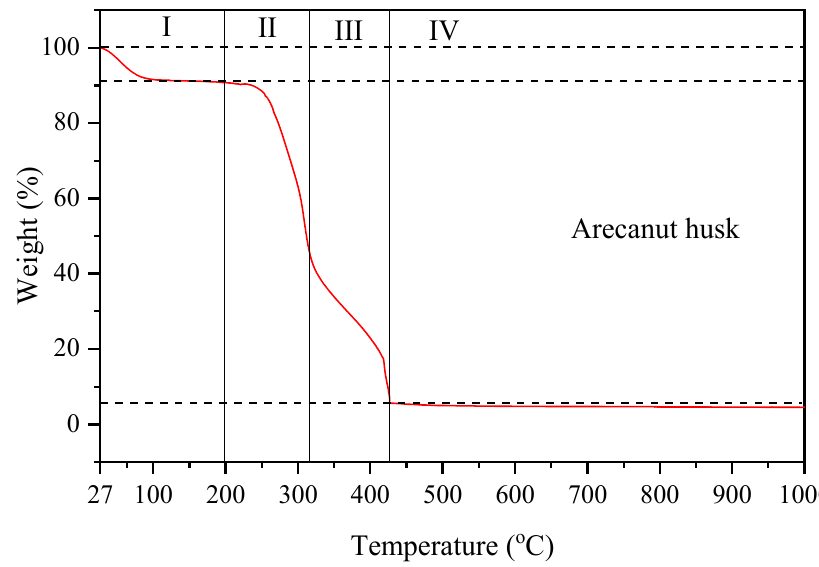
Figure 3. Thermogravimetry analysis (TGA) of arecanut husk.